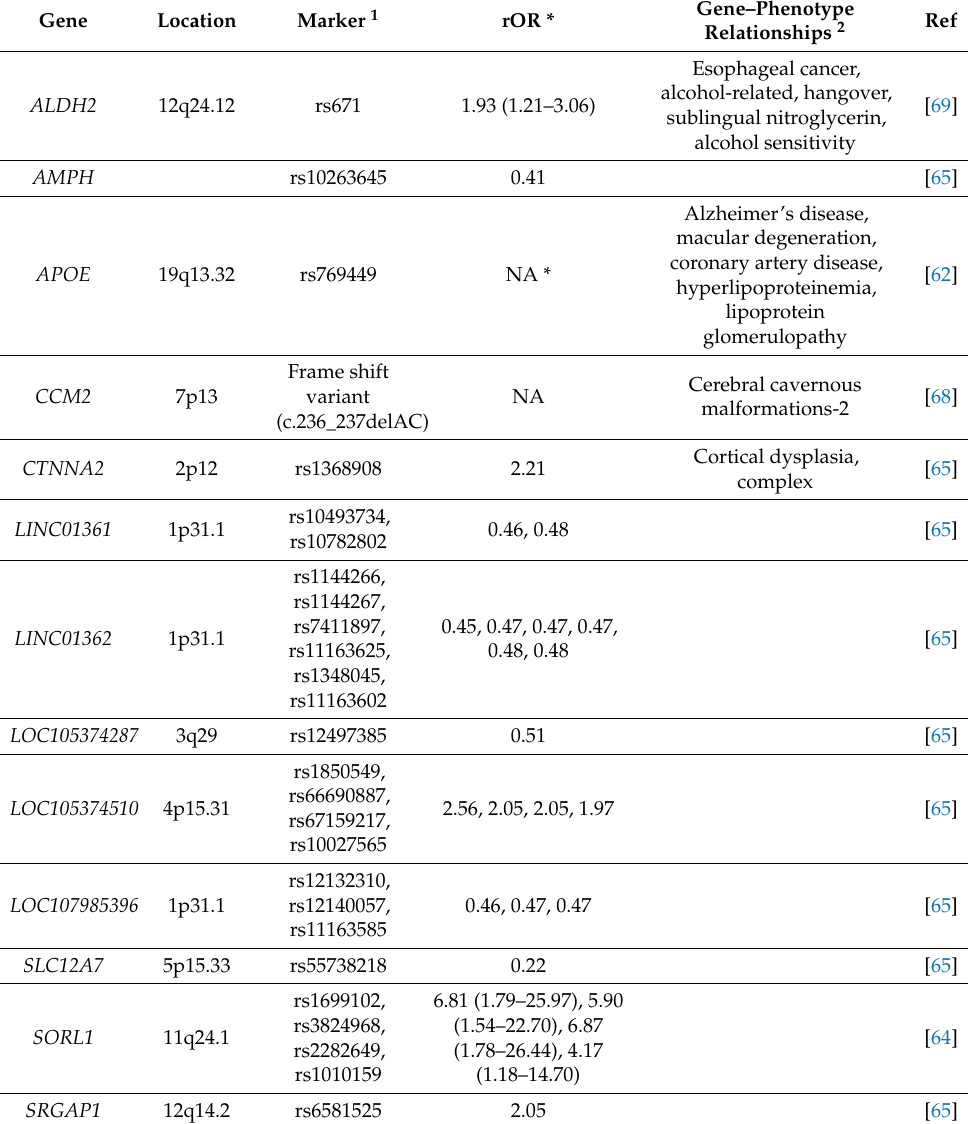
Table 4. Genes Associated with both to Cerebral Microbleeds and